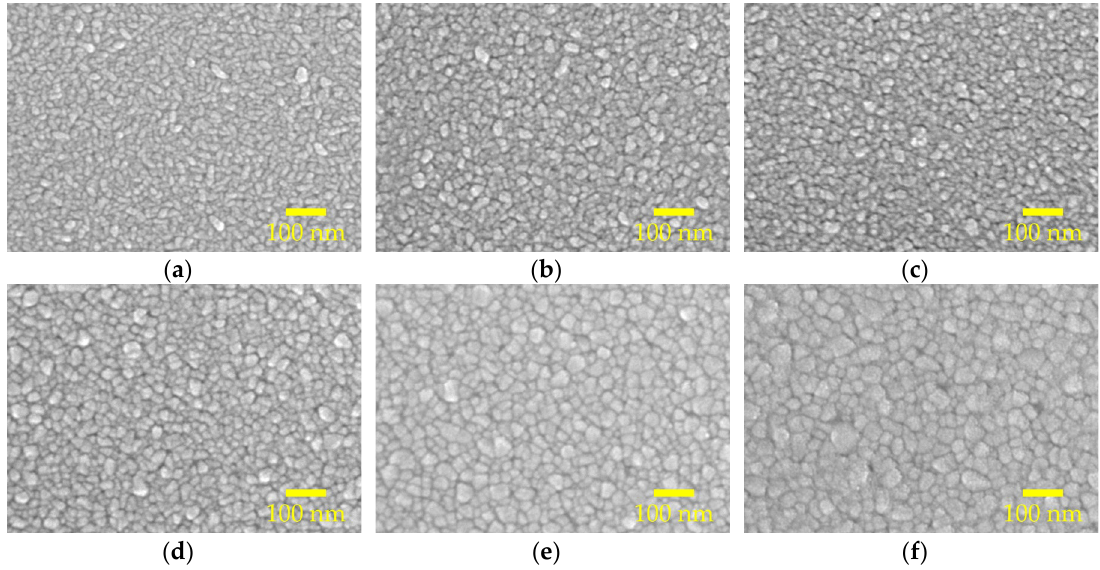
Figure 3. SEM morphological images of the AALD Al:ZnO films annealed at ( a ) 300, ( b ) 400, ( c ) 500, ( d ) 600, ( e ) 700, and ( f ) 800 °C.